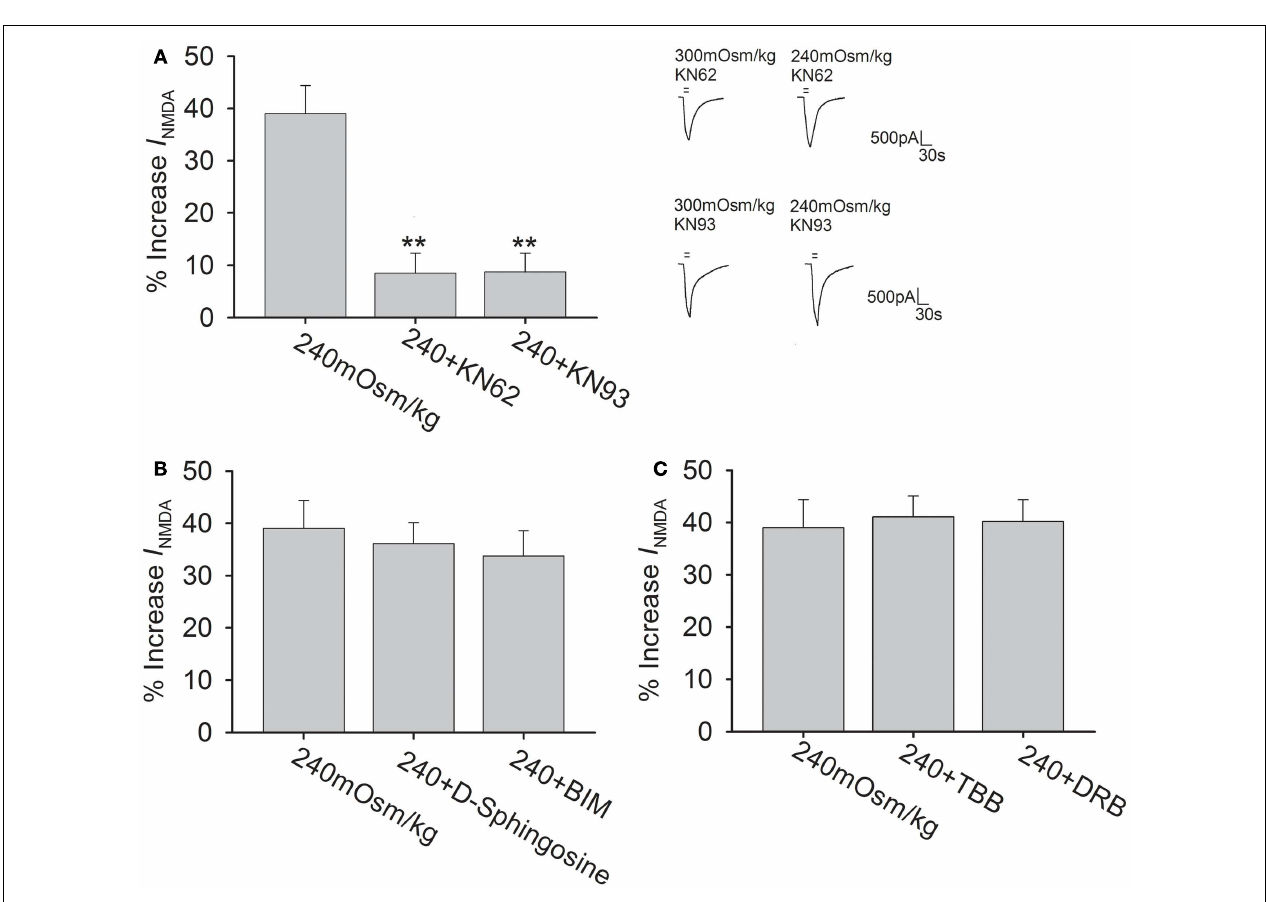
FIGURE 5 | CaMKII antagonists attenuate hypotonicity-increased I NMDA. (A) In the presence of KN62 or KN93, I NMDA was almost not affected by hypotonic stimulation and the increase in I NMDA by hypotonicity was markedly blocked by pre-application of KN62 or KN93. ** P < 0.01 vs. 240mOsm/kg. (B)